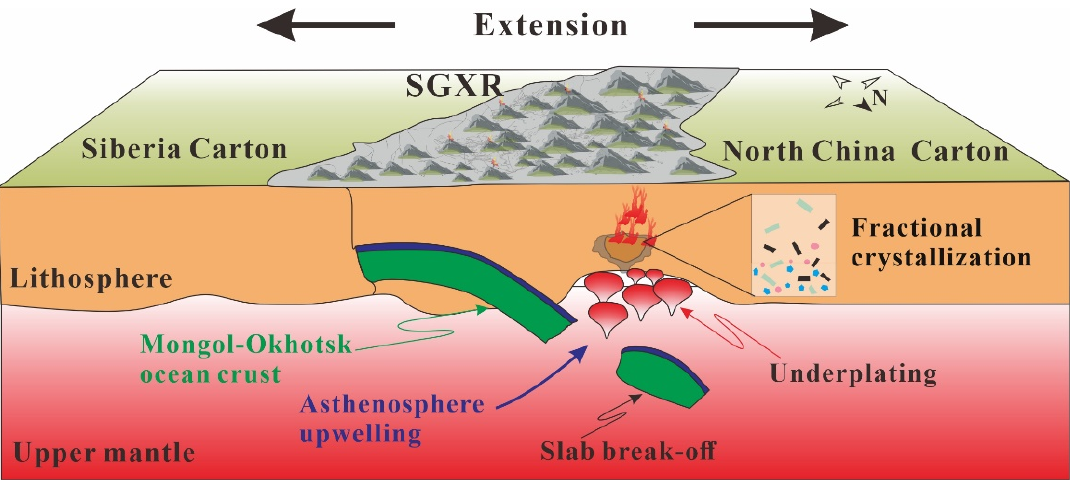
Figure 10. Schematic model for the early Early Cretaceous tectonic evolution of the SGXR.